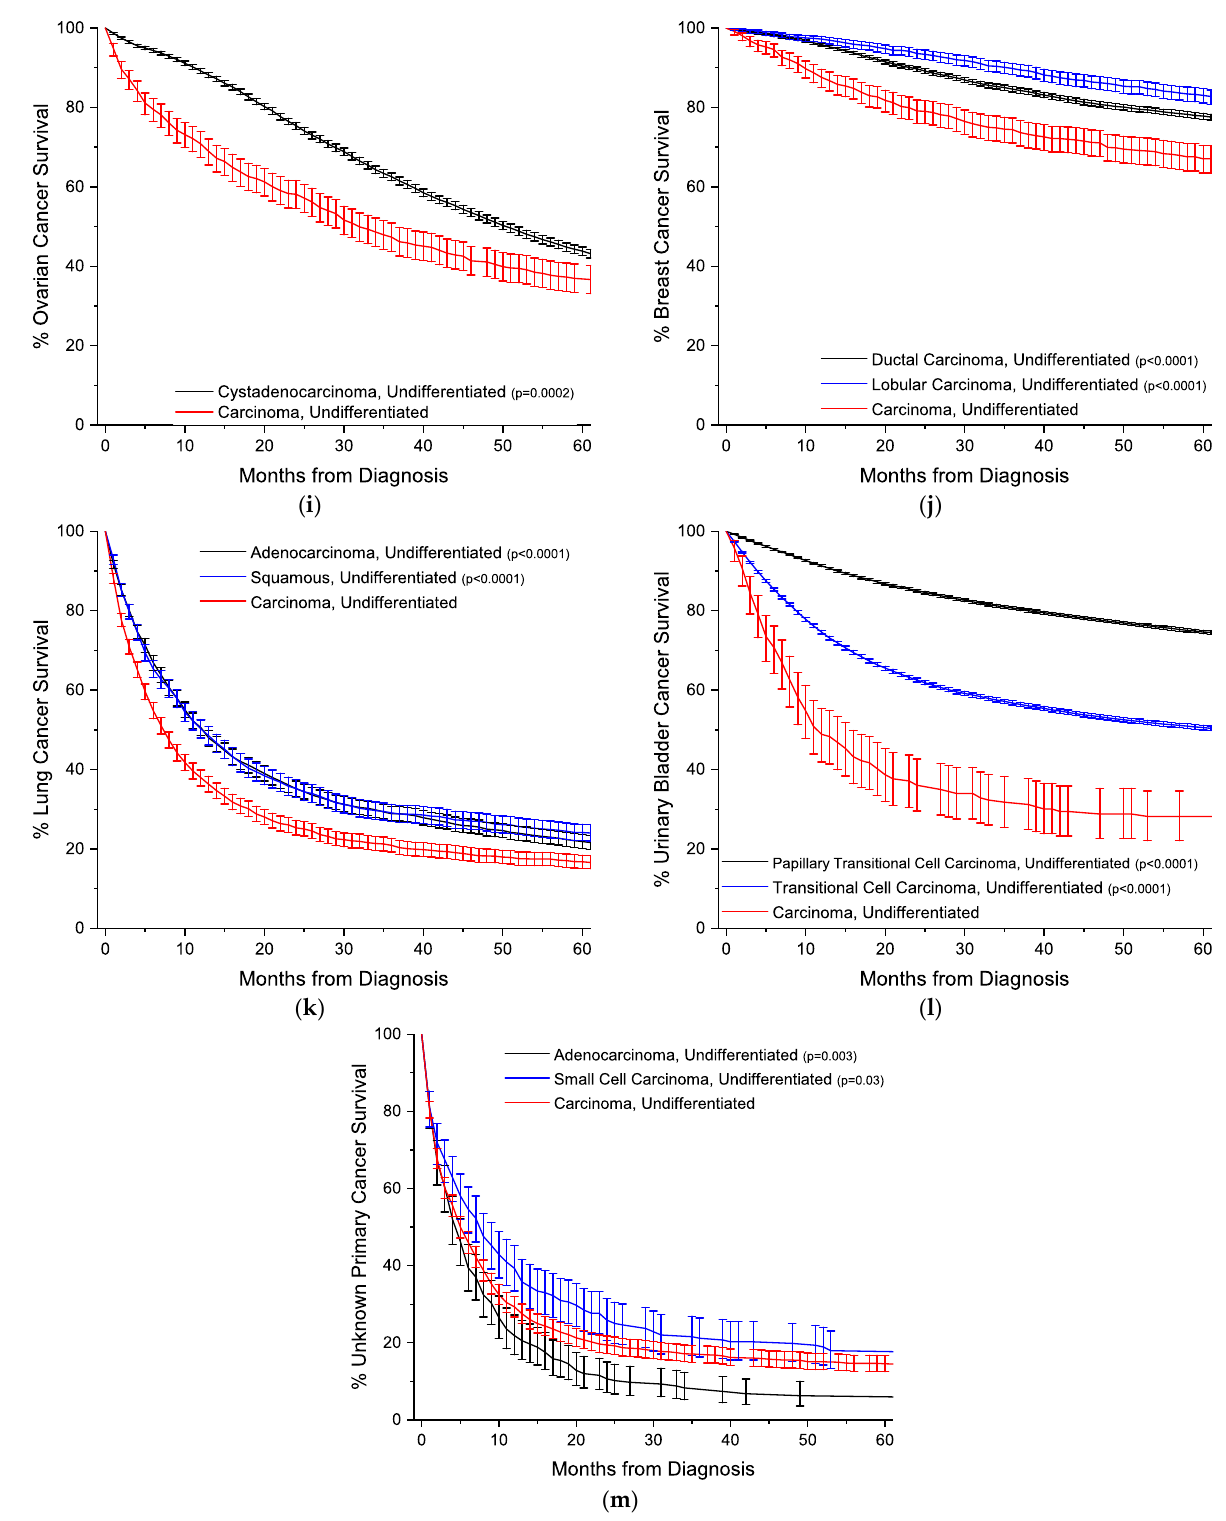
Figure 3. Kaplan–Meier overall survival curves. All survivor functions are shown with 95% confidence intervals. ( a ) Nasopharyngeal cancer. ( b ) Salivary gland cancer. ( c ) Thyroid cancer. ( d ) Esophageal cancer. ( e ) Gastric cancer. ( f ) Colorectal cancer. ( g ) Pancreatic cancer. ( h ) Uterine cancer. ( i ) Ovarian cancer. ( j ) Breast cancer. ( k ) Lung cancer. ( l ) Urinary bladder cancer. ( m ) Unknown primary cancer. All p -values are relative to the Carcinoma, Undifferentiated group.